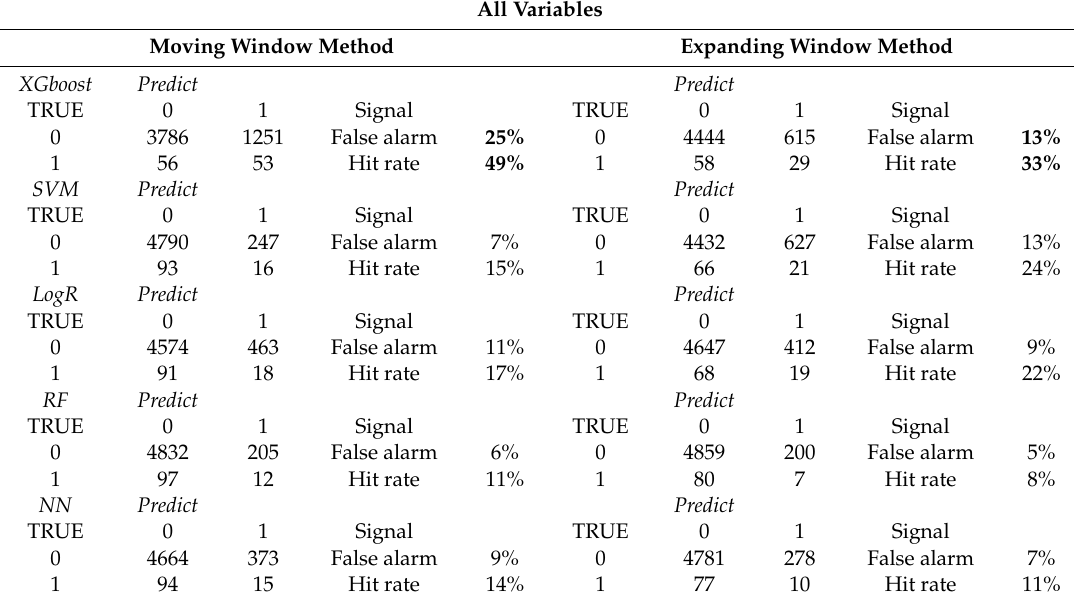
Table 11. Confusion matrix results: All